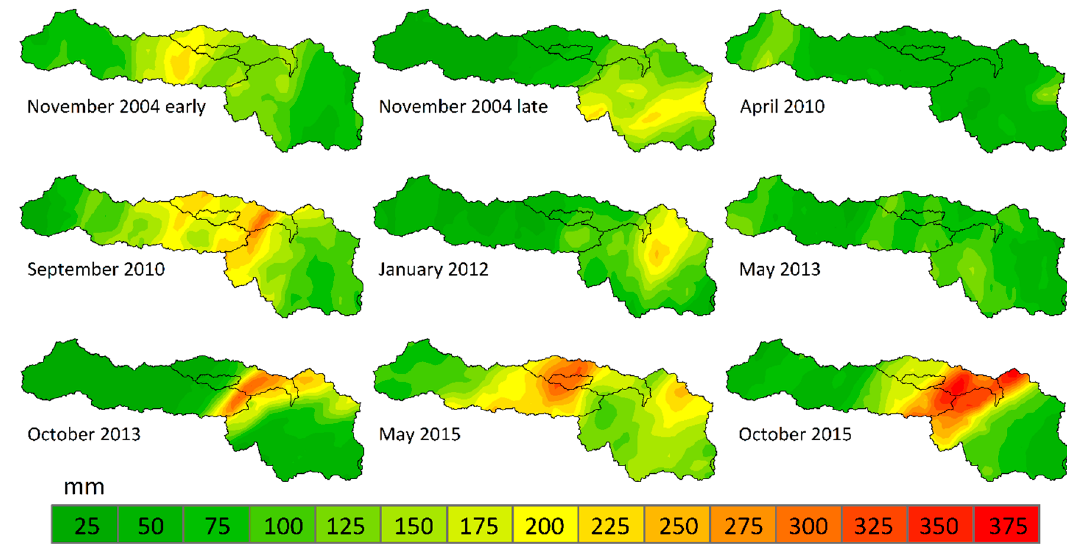
Figure 2. Total accumulations from stage IV data for individual storm events used in the analysis (mm). The month and year in which the storm occurred is displayed along with outlines of the interior watersheds. Numbers along the legend represent the maximum value from each category.